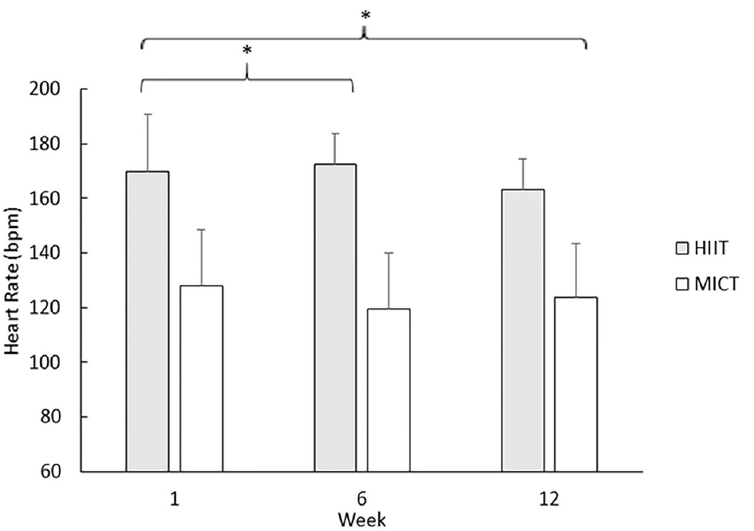
Fig 1. Mean (SD) HR at week 1, 6 and 12. � denotes significant difference from week 1 ( p <